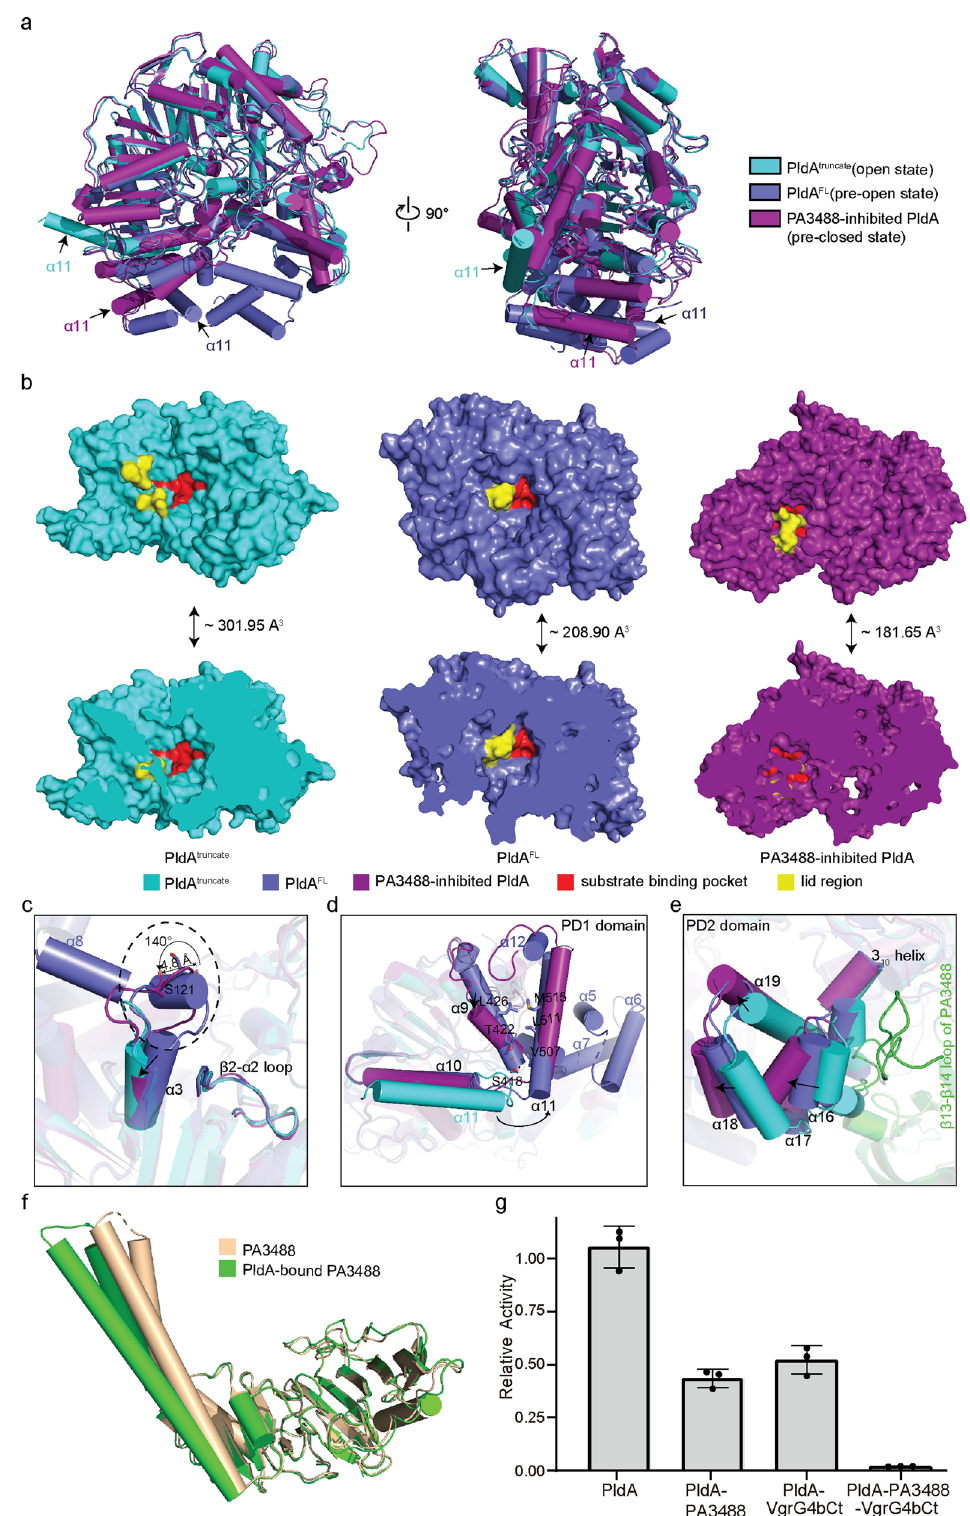
Fig. 5 | PA3488 binding results in conformational changes in the structure of PldA and associated enzymatic assays. a Structural comparison of PldA truncate , PldA FL and PA3488-inhibited PldA. b Surface (up) and cross-sectional (down) representationofactivepocketsfromPldA truncate ,PldA FL andPA3488-inhibitedPldA. Thelidregionandtheactivesitearehighlightedinyellowandredrespectively.The volume of each pocket in PLDs is calculated through a web server-CASTp 3.0